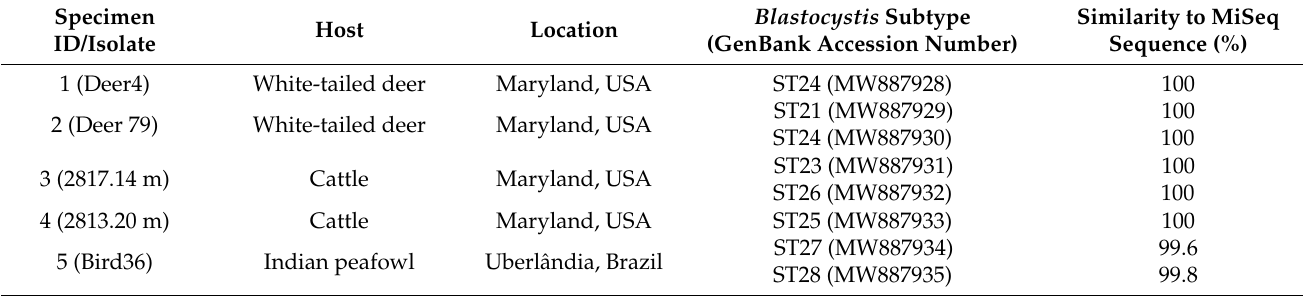
Table 1. Information of Blastocystis specimens used in this study including host, geographic origin, and subtype. Specimen